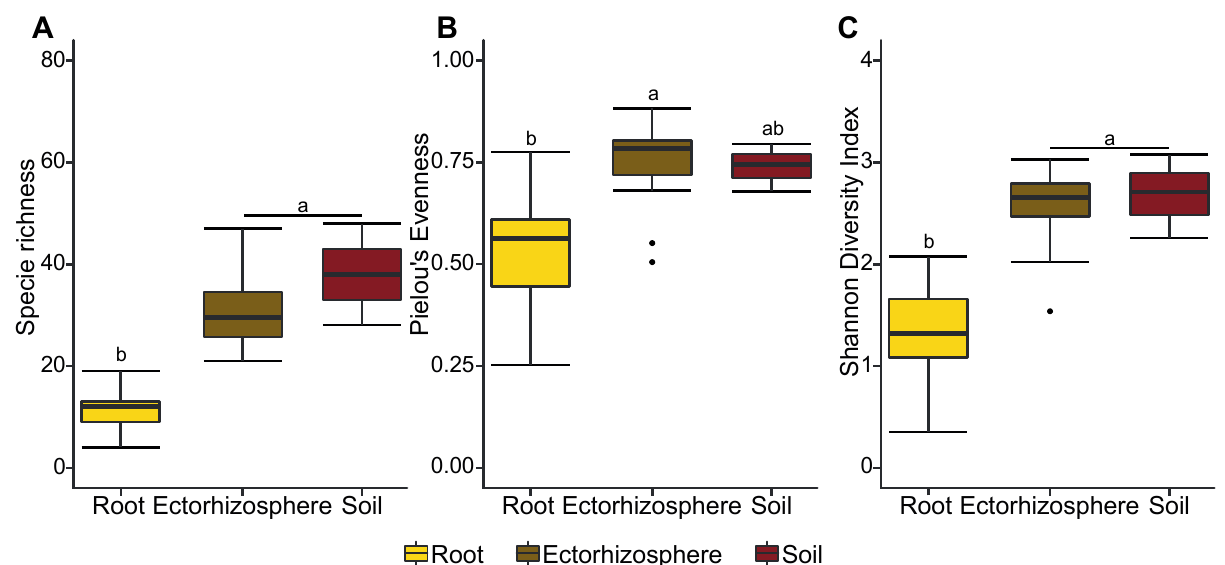
Figure 3. Boxplots of ( A ) species richness, ( B ) Pielou’s evenness, and ( C ) Shannon diversity of control samples of roots, ectorhizosphere and scarified soils. Lowercase letters in the upper part of the boxplot represent Fisher’s least significant difference (LSD) statistical grouping testing scheme 1.5 × inter-quartile range (IQR).